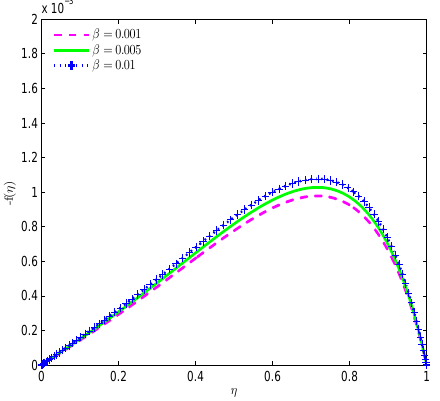
Fig. 8: Variation of f with β at α = 0.01 , γ = 0.01 , Re = 10.0 , K = 10.0 and Λ = 0.001 .